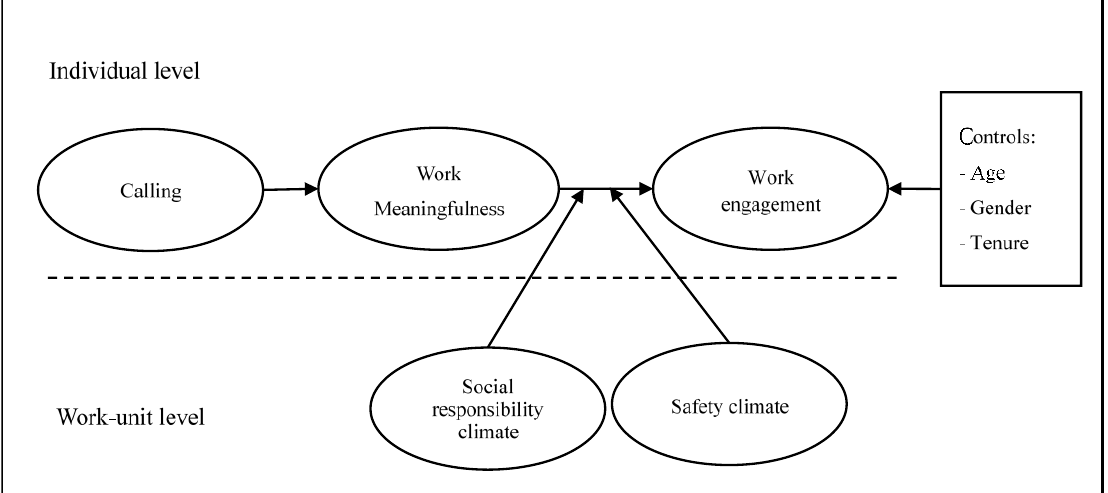
Figure 1. Research